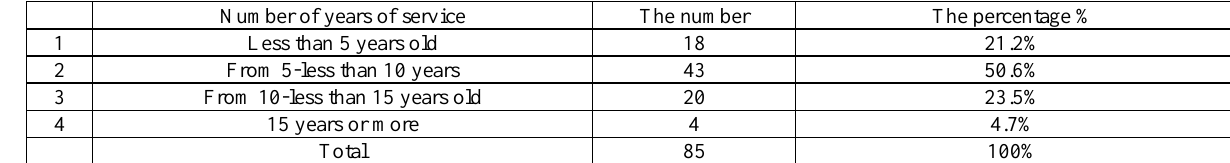
Table 7. Distribution of members of the study sample according to the number of years of service Number of years of service The number The percentage % Less than 5 years old